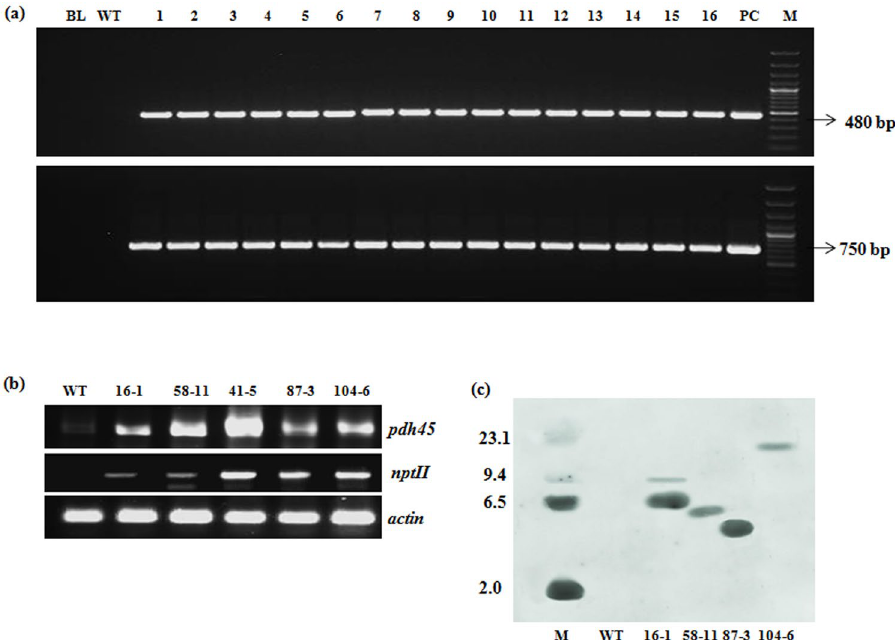
Figure 1. Molecular analysis of transgenic events in T 3 generation. ( a ) PCR (BL = blank, WT = wild type, lane 1–16 = representative samples of putative transformants, PC = plasmid; M = 100 bp DNA marker- PCR and lamba Hind III digest-genomic Southern analysis); ( b ) sqRT-PCR; and ( c ) Genomic southern analysis of Hind III digested genomic DNA for ascertaining transgene ( npt II) copy number in the transgenic events.